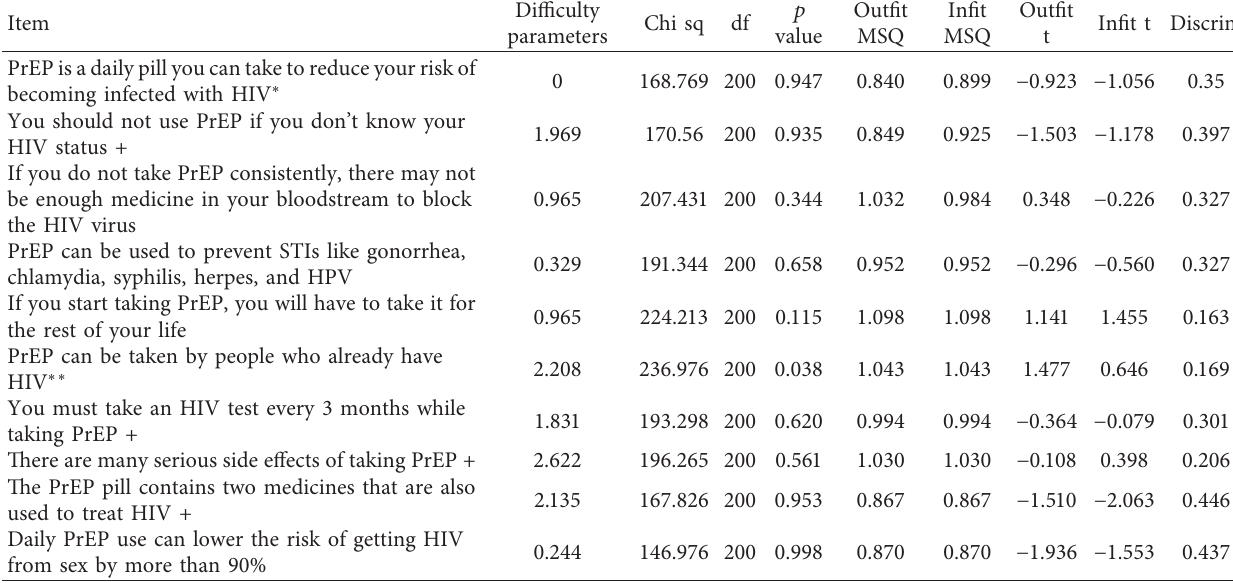
Table 2: Item response analysis—PrEP knowledge